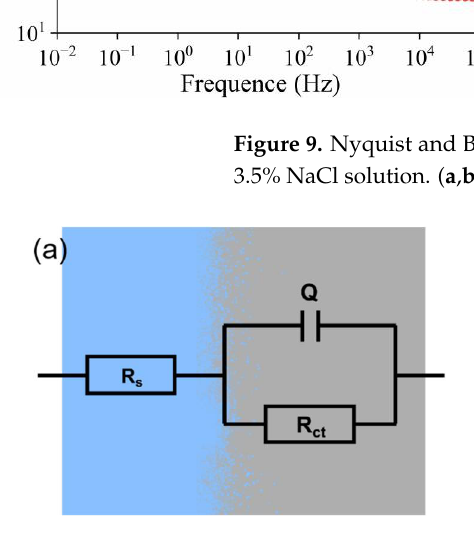
Figure 10. Best equivalent circuits used for modeling the EIS spectrum. ( a ) Equivalent circuits for the delivered, S1160 and A850 samples, and ( b ) equivalent circuits for DN450-8, SN450-8 and AN450-8 samples.